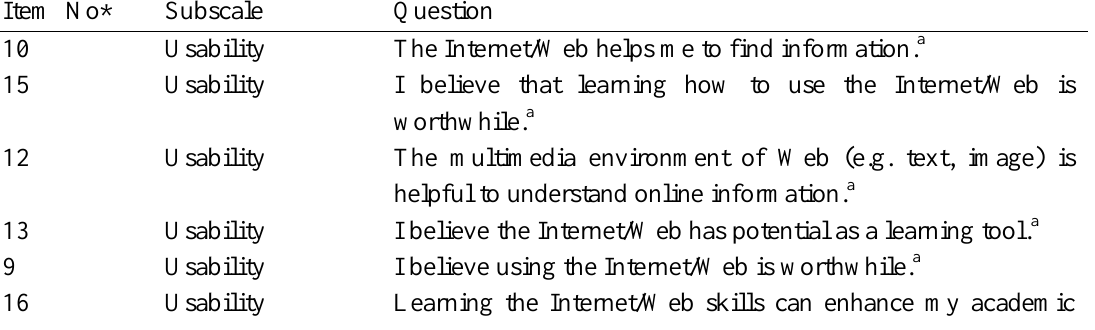
The Items and the Factors (Subscales) on the Attitude Scale toward the Web Item